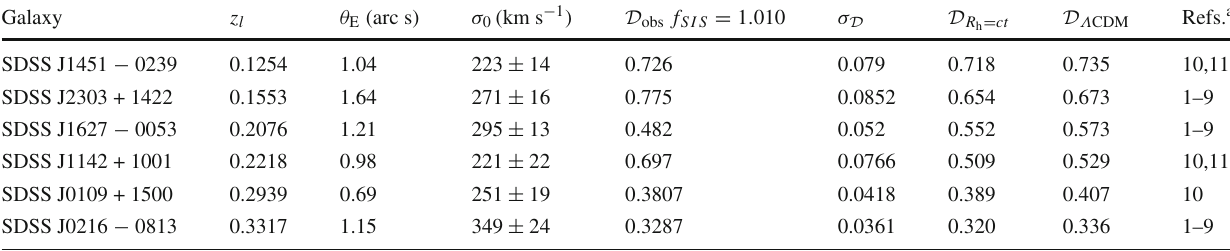
Table 3 Strong gravitational lensing systems with 0 . 5 < z s < 0 . 525